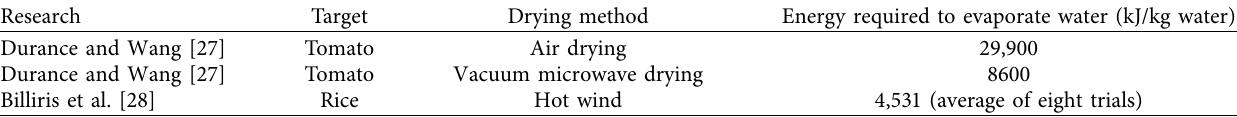
Table 2: Energy required for a grain dryer to dehydrate 1 kg of